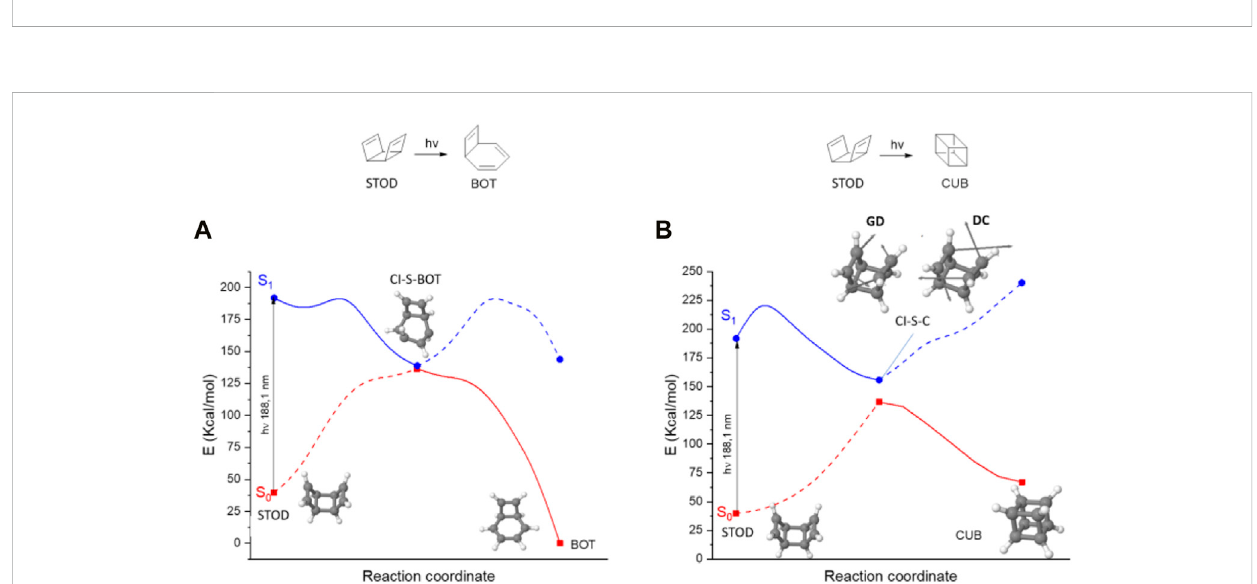
FIGURE 5 Different CASSCF photochemical pathways initiated by STOD S 0 → S 1 photon absorption: (A) STOD → BOT and (B) STOD → CUB. The energy graph is shown in adiabatic fashion (S 0 : red and S 1 : blue) with the continuous lines corresponding to the populated potential energy surfaces necessary to reach the respective photoproduct. Geometrical structures of S 0 minima and S 1 /S 0 conical intersections are shown, including in the case of CI-S-C the non- adiabatic coupling vectors: gradient difference (GD) and derivative coupling (DC)